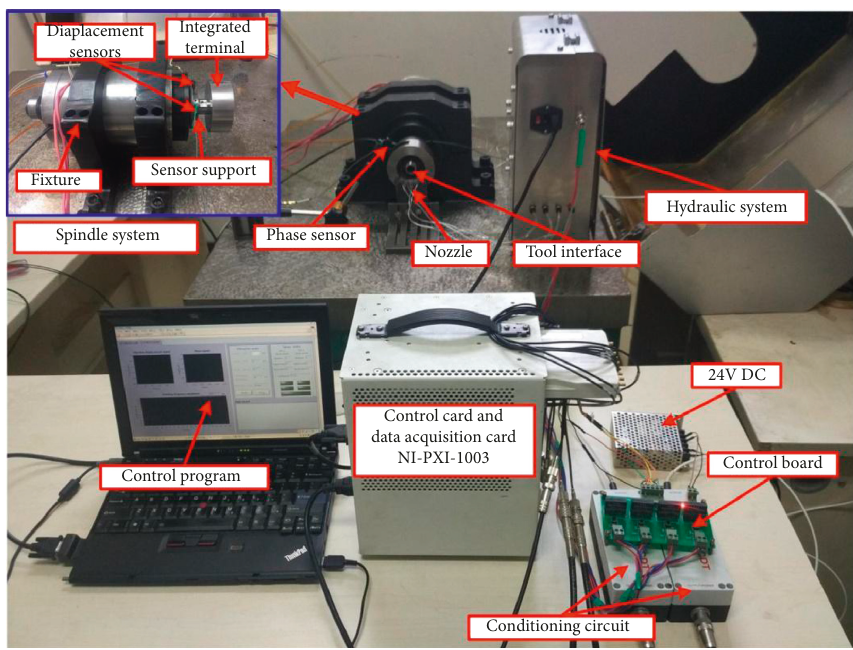
Figure 17: Experimental